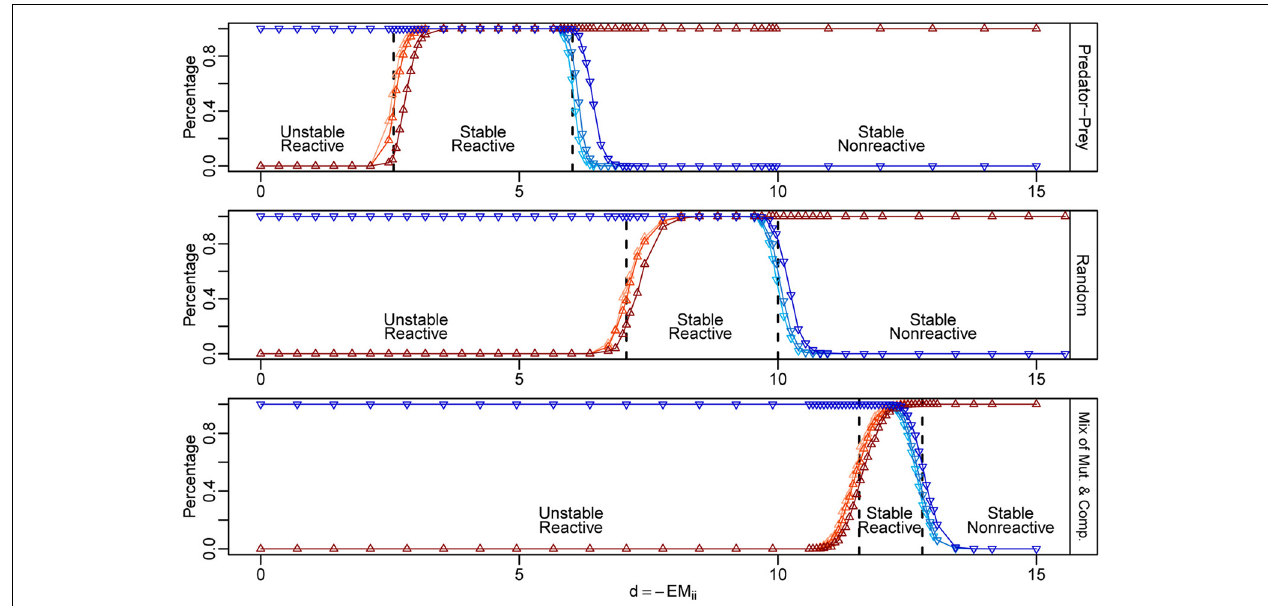
FIGURE 2 | Numerical simulations for the phase transitions of stability and reactivity in three types of ecological networks. The y -axis represents the probability of stability (red) and reactivity (blue) computed from 1000 random community matrices for each case. We built matrices choosing the joint density of ( X 1 , X 2 ) as shown in Figure 1 . For each type of matrix, we fixed S = 250, C = 0 . 2, and E = 0. The critical points ( d crit , 1 , d crit , 2 ) for the stability-instability and reactivity–non-reactivity